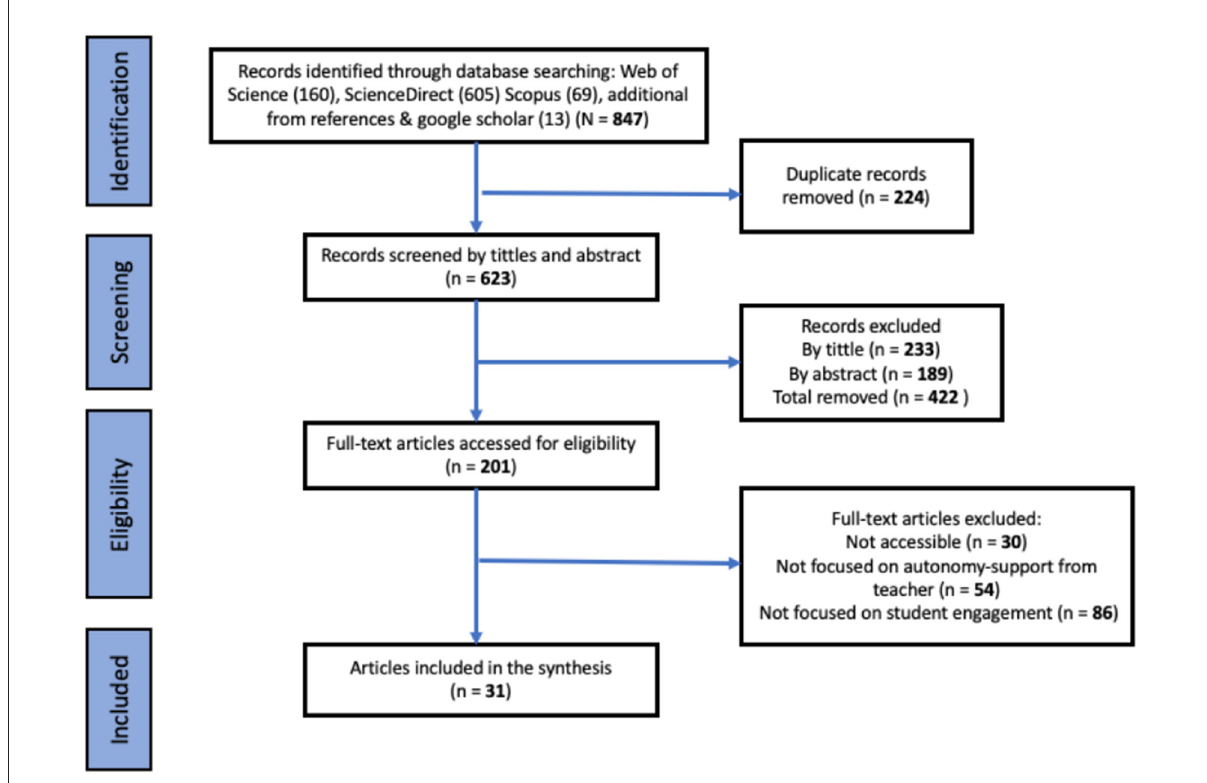
FIGURE1 PRISMA style article identification flow.